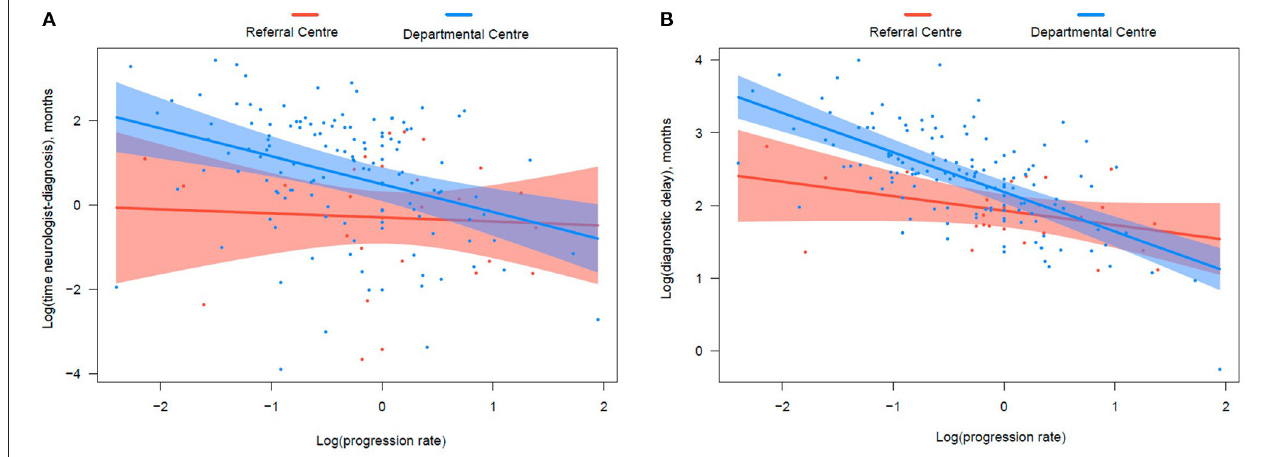
FIGURE 3 | Graphical representation of the effect of the interaction between the progression rate and the center in the time neurologist-diagnosis (A) and diagnostic delay (B) . In the referral center (red), both the time neurologist-diagnosis and diagnostic delay remain relatively stable despite variations in the progression rate. Conversely, in the departmental center (blue), the progression rate has a huge influence in both times. The confidence intervals (shaded colors) are wider in graphic A than B, which explains that this effect, although visible in both graphics, is only statistically significant in the latter but not in the former model.